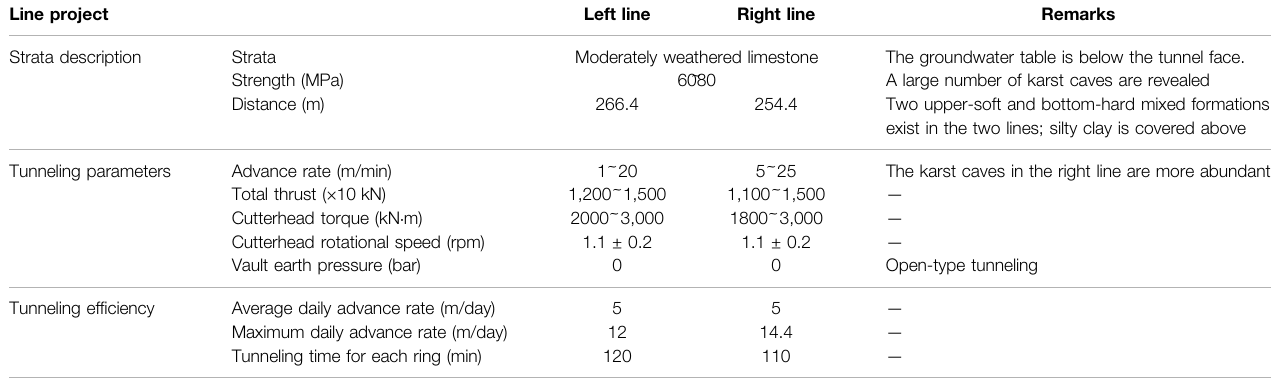
TABLE 3 | Comparison of the shield tunneling performance on the left and right lines in the fi rst section (air shaft-to-Dayangzhuang Station) at the karst area. Line project